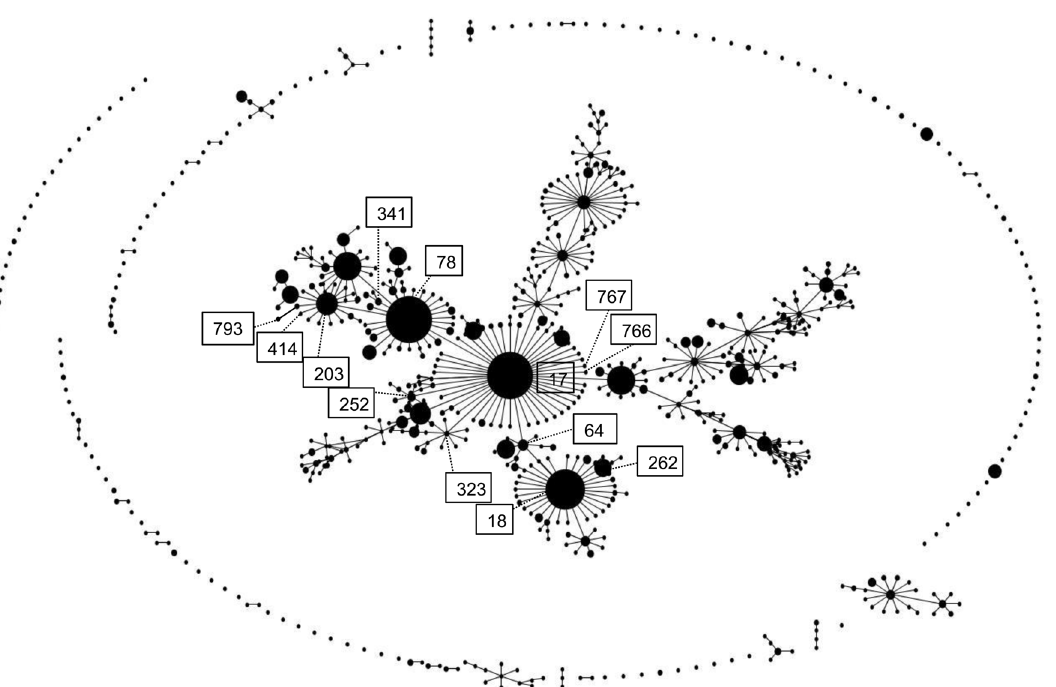
Fig. 1. eBURSTanalysis of the 134 VRE isolates in the present study and those published MLST database. Each ST is presented as a dot. The size of each dot corresponds to the number of isolates in the ST. The 13 STs found in this study are indicated in boxed